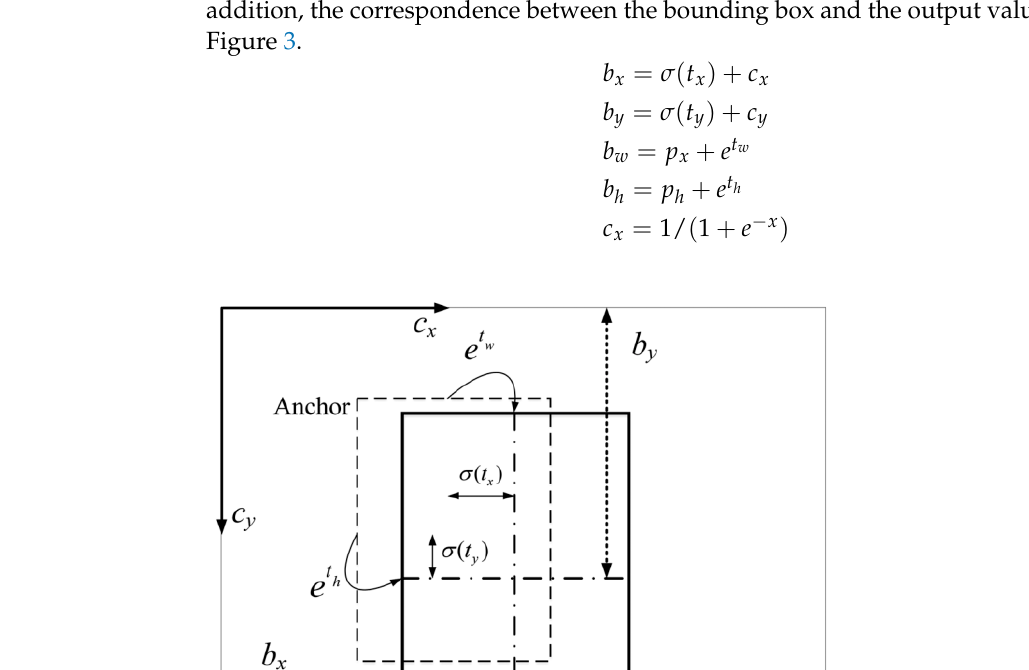
refer to the offset relative to the upper left. In